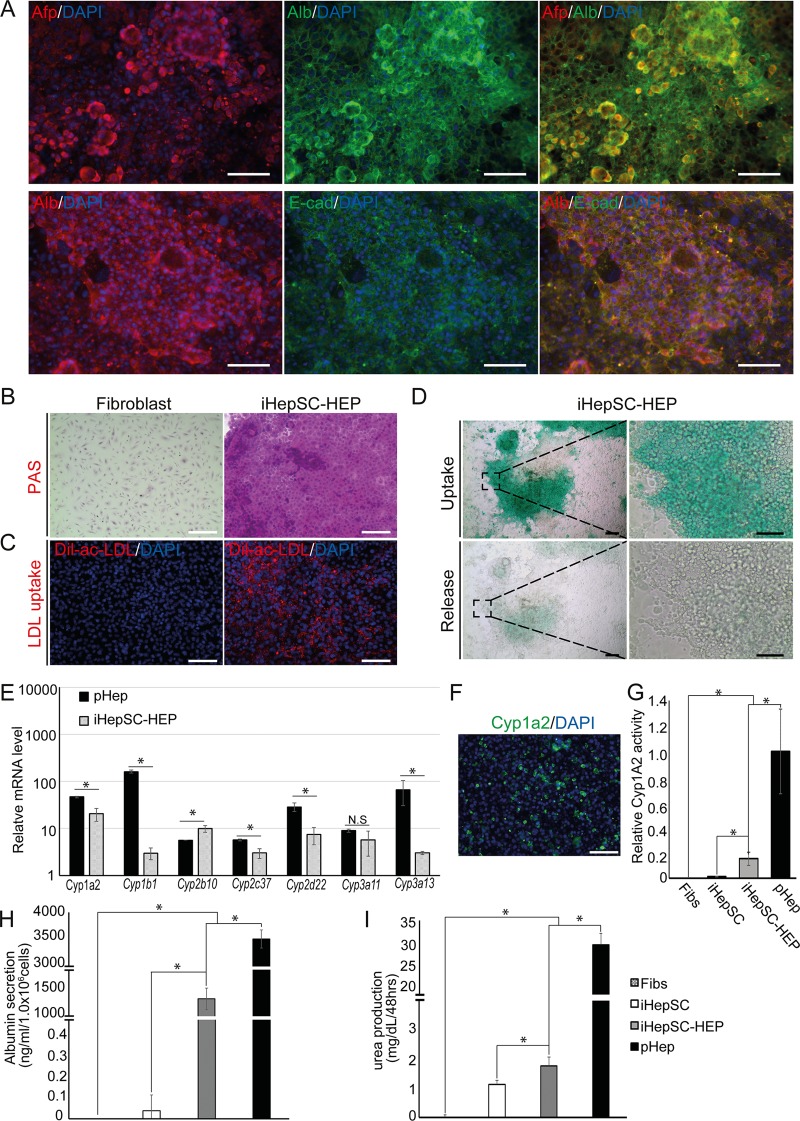
Characterization of iHepSC derived-hepatocyte (iHepSC-HEP).(A) Immunofluorescence images of iHepSC-HEP expressing hepatocyte markers (α-fetoprotein: Afp; Albumin: Alb; E-cadherin: E-cad). The nucleus was stained with DAPI. Scale bar: 150 μm. (B) Image of Periodic acid-Schiff (PAS) stained iHepSC-HEP. (C) Image of acetylated low-density lipoprotein (LDL) uptake in iHepSC-HEP. (D) Detoxification capacity evaluated by indocyanine green (ICG) uptake and release assay. The nucleus was stained with Hematoxylin and DAPI. Fibroblasts were used as negative control. The black dashed boxes were enlarged. Scale bars: 150 μm. (E) The mRNA expression levels of Cytochrome P450 (CYP) family in iHepSC-HEP and primary hepatocyte (pHep) were analyzed by qPCR. iHepSC-HEP and pHep were incubated with inducers (3-methylcholanthrene and Rifampicin) for 72 hrs. The mRNA expression levels were normalized by the levels in cells without inducer treatment. Error bars indicated standard errors from triplicate samples (n = 3). *, P<0.05. (F) Immunostaining image of iHepSC-HEP stained with Cyp1a2. The nucleus was stained with DAPI. Scale bar: 150 μm. (G) The activity of Cyp1a2 in response to 3-Methylcholanthrene (50 μM). (H-I) The amount of Albumin secretion (H) and Urea production (I) of iHepSC-HEP in comparison with fibroblast (Fibs), iHepSC and pHep were examined by ELISA. Error Bars indicate standard errors from triplicate samples (n = 3). *, P<0.05.